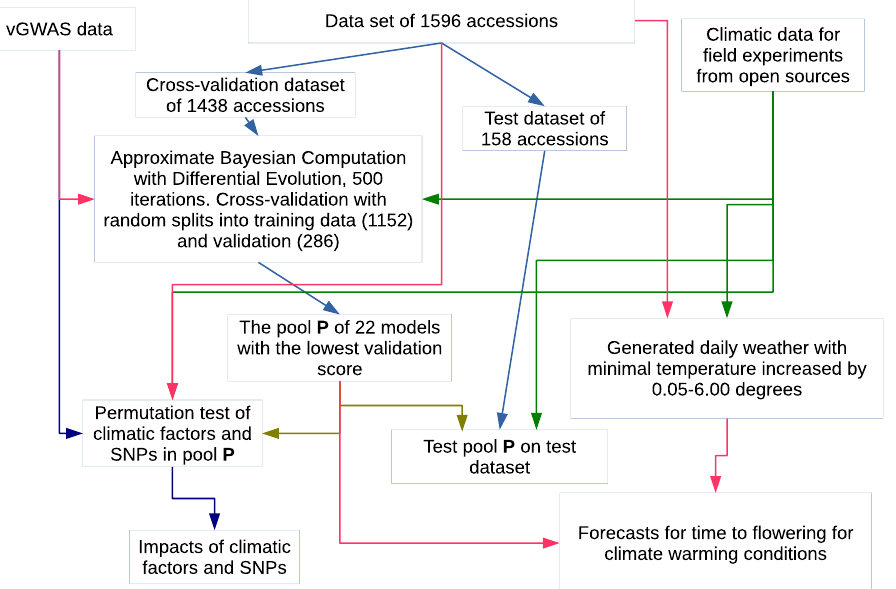
Figure 1. The overview of the research. The datasets, performed numerical experiments and results are shown as boxes on the diagram while the arrows represent the data